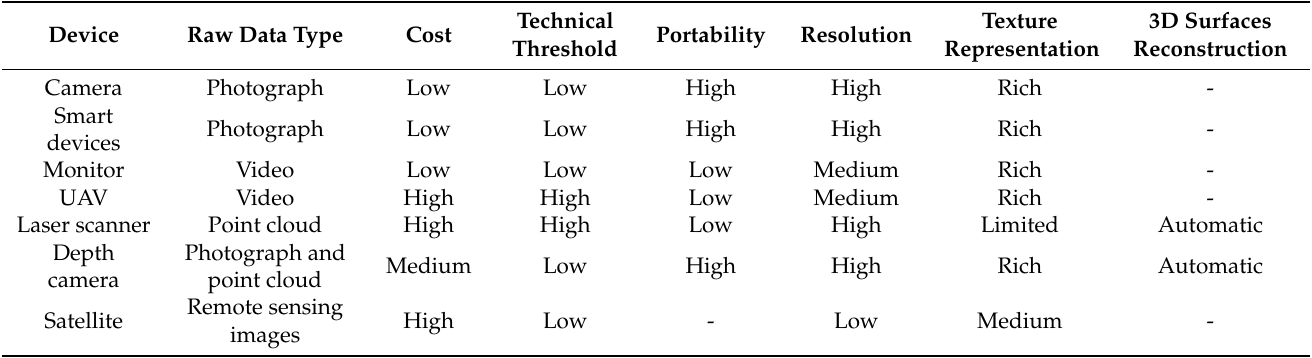
Table 2. Device performance